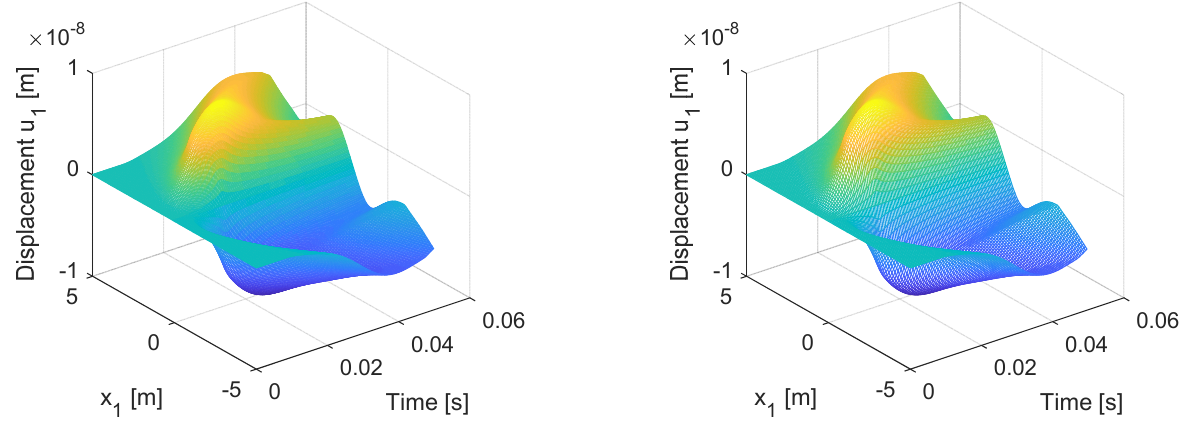
Figure 7. Time history of u 1 at x 3 = − 1 generated by the analytical solution (left) and the SBM-EWM (right).